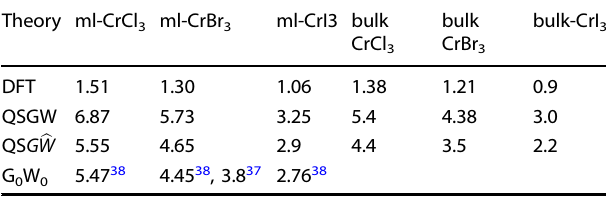
Table 1. Electronic band gaps in bulk and monolayer.